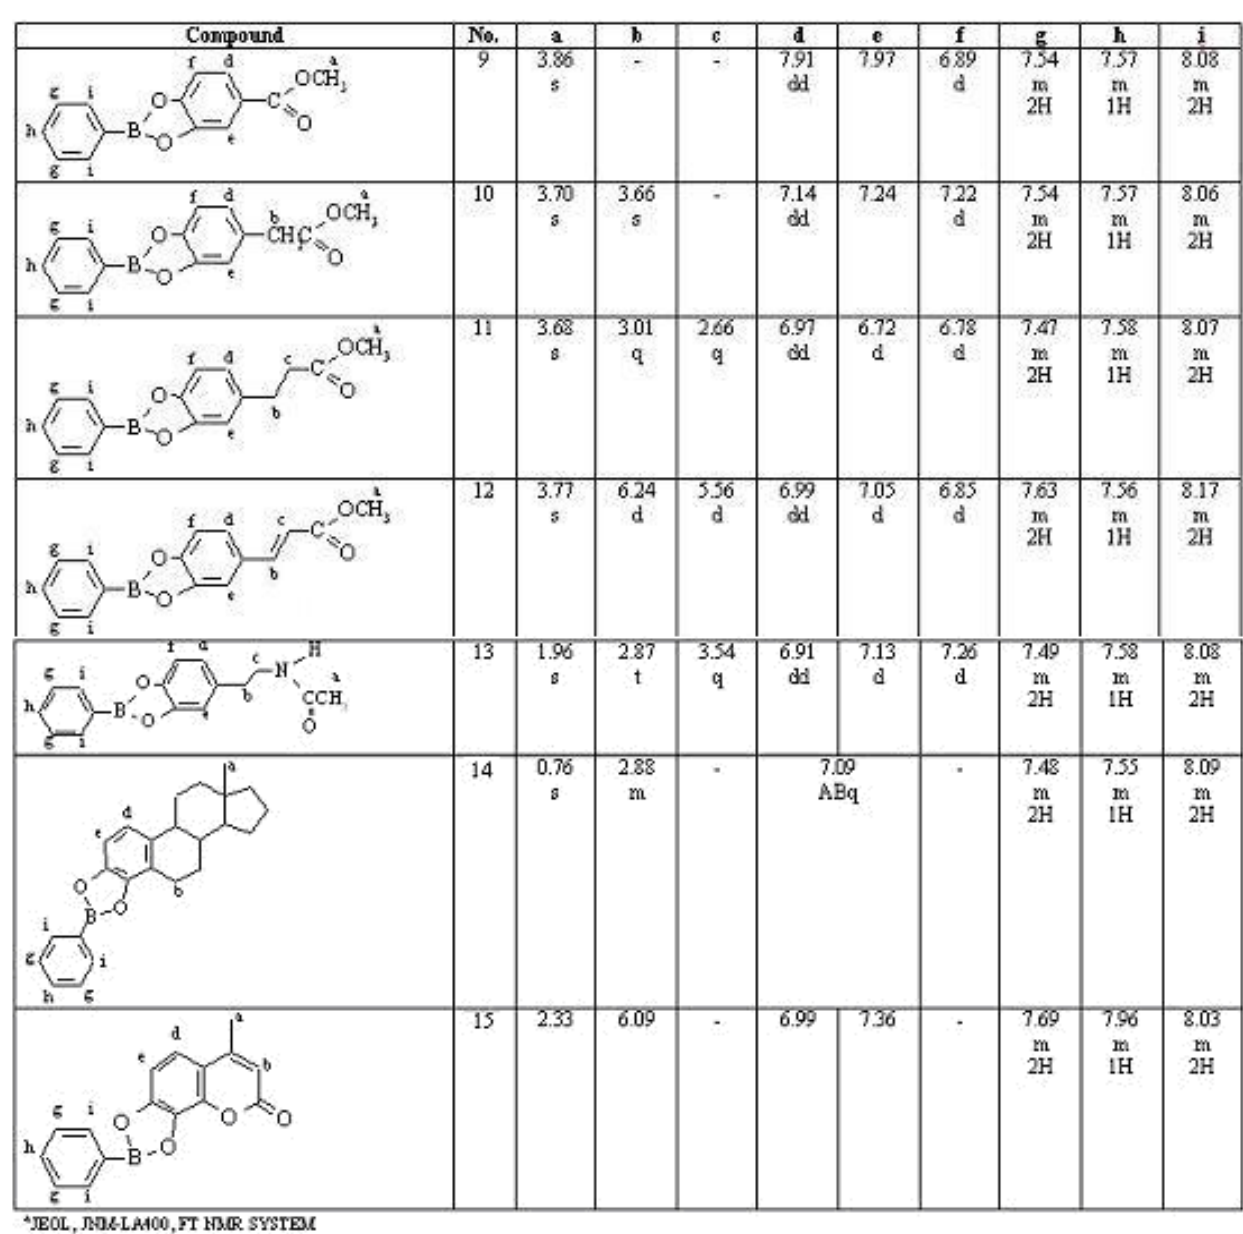
Figure 2. 1 H-NMR, characteristic proton chemical shifts (=ppm), of the